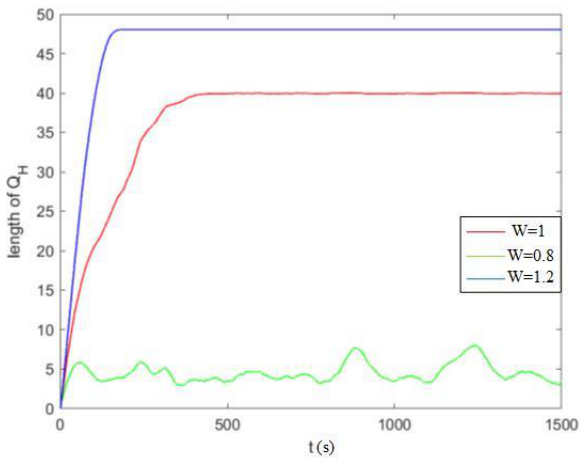
Figure 6. Comparison of average delay(s) under different packet arrival rates.